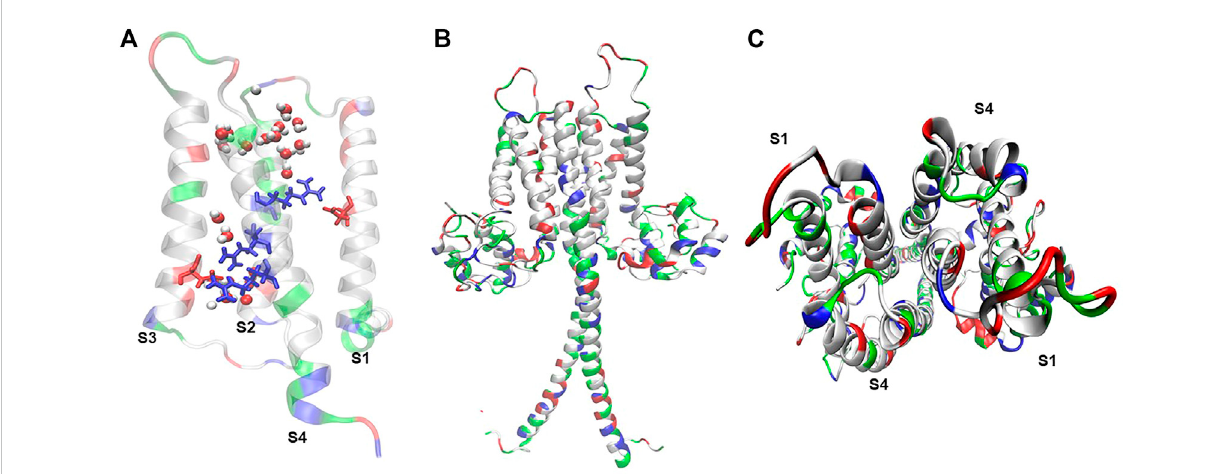
FIGURE 1 Hv1 re fl ects molecular arrangements that sustain its voltage-dependent conduction. (A) Truncated mHv1 lacking its N and C cytoplasmic terminal domains (PDB code: 3WKV, Takeshita et al., 2014) simulated in a POPC membrane bathed with a 150 mM NaCl salt solution for 0.5 ns (36141 atoms). In white: apolar residues, in green: polar residues. It isshown inblue(from up to down) three argininesrelated to theS4 domain,from up-to-down: Arg205 (R1),Arg 208(R2) and Arg 2011(R3), inred Asp112in S1and Asp174 inS3, andwaters inVDW representation. (B) Full length mHv1in dimerform, built fromthe bestmodelscored of 10000 N terminal modelsby usingRosetta Ab initiorelaxapplication(Bradley et al.,2005), atruncated hHv1 lacking N and Cterminaldomains(PDBcode:5OQK,Bayrhuberetal.,2019)andthecoiled-coildimerizationCterminaldomain(PDBcode:3VMX,Fujiwaraetal.,2012). FulllengthhHv1wasduplicatedandpositionedeachmonomerinfrontoftheirS1-S4interphasefollowingcross-linkinganddimericdata(Leeetal.,2008; Mony et al., 2020) and simulated for 1 ns embedded in POPC bathed with an aqueous saline solution of 150 mM (123017 atoms). (C) Top view of the full length mHv1 S1-S4 dimer